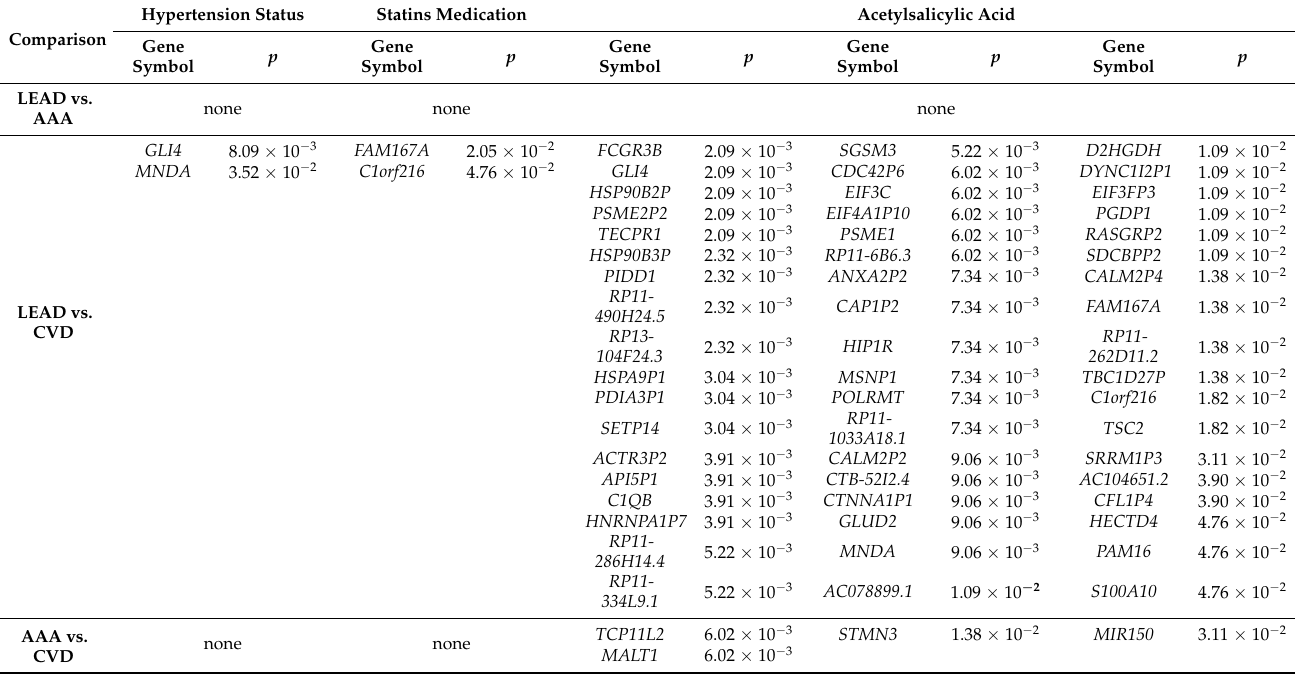
Table 4. Relationships between categorical characteristics of study subjects (smoking and hypertension status, medication with statins, acetylsalicylic acid and beta-adrenergic blockers) and expression of 89 genes selected from LEAD vs. AAA, LEAD vs. CVD and AAA vs. CVD comparisons. The table presents genes with statistically significant relationship (Benjamini–Hochberg FDR adjusted p < 0.05) obtained from two-sided Mann–Whitney U test (the entire results are provided in Supplementary File